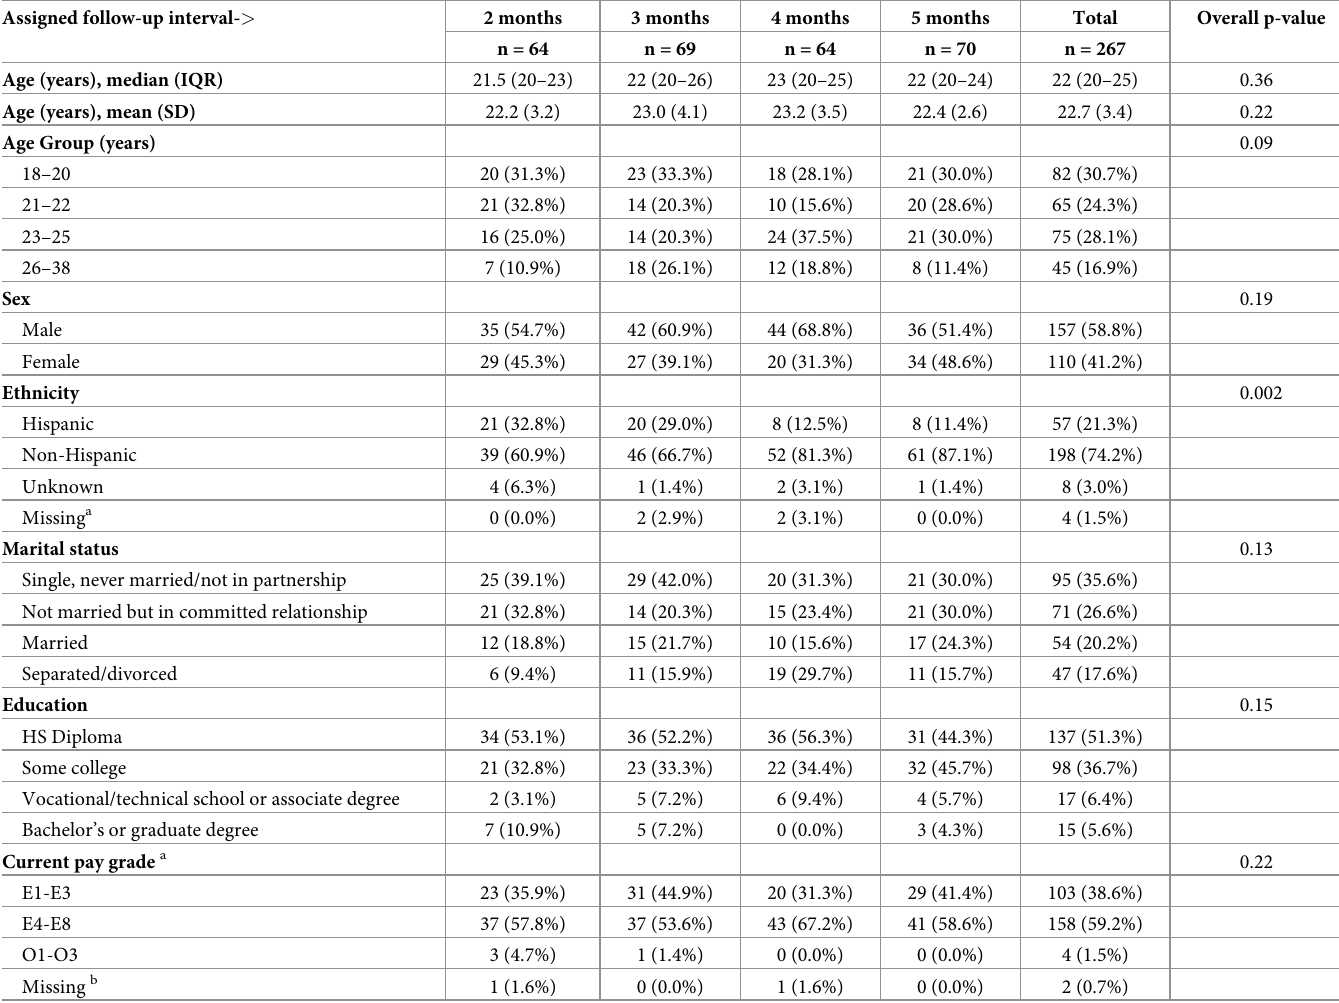
Table 2. Demographic characteristics of study participants who completed a follow-up visit prior to the final (6-month) visit. Assigned follow-up interval-